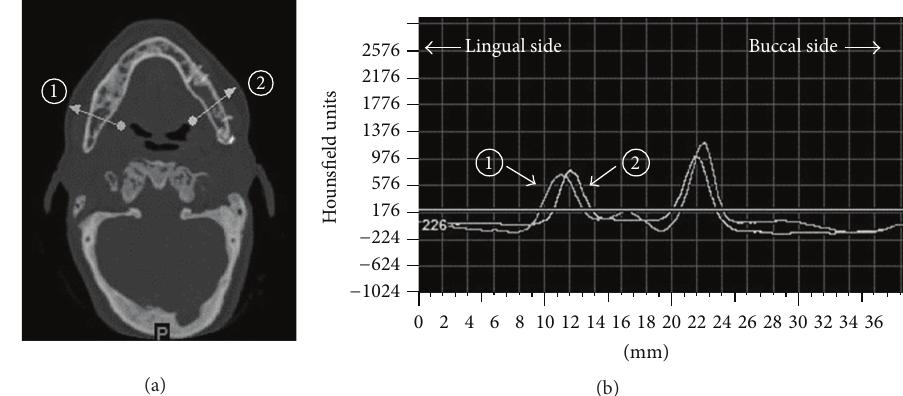
Figure 6: Bone density measurement using CT images and values [163]: (a) the regenerated bone shows no resorption 8 years postoperatively. The bone density was measured in 2 areas (one healthy bone area (1) and one regenerated bone area (2)) (arrows), and (b) the bone density. The peak of the cortical bone density was remarkably not different for the regenerative bone and the healthy bone.